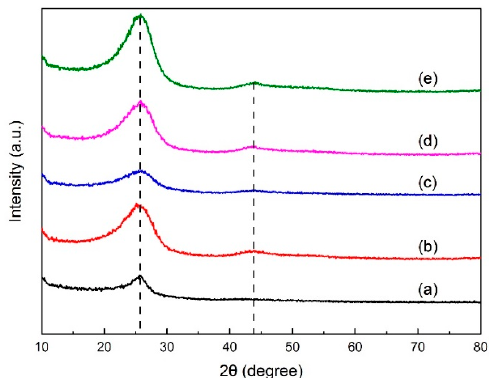
Figure 2. X-ray diffraction (XRD) patterns of (a) green petroleum coke, (b) graphene, (c) N-GLPs 350 2 , (d) N-GLPs 550 2 , and (e) N-GLPs 750 2 . (d) N-GLPs 550 2 , and (e) N-GLPs 750 2 FT-IR